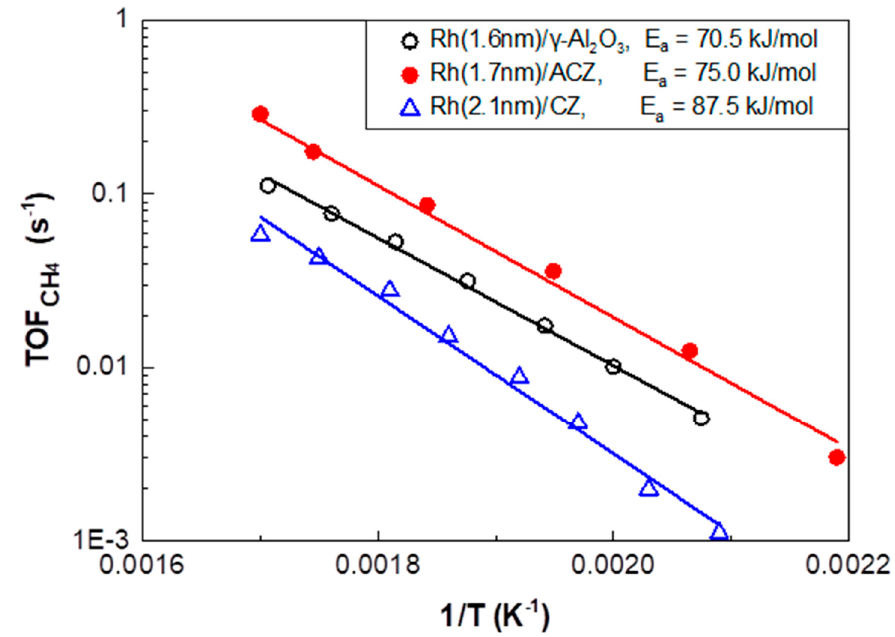
Figure 3. Arrhenius plots of the CH 4 formation turnover frequency ( TOF CH4 ) obtained for Rh(1.6nm)/ γ -Al 2 O 3 , Rh(1.7nm)/ACZ, and Rh(2.1nm)/CZ catalysts obtained under differential reaction